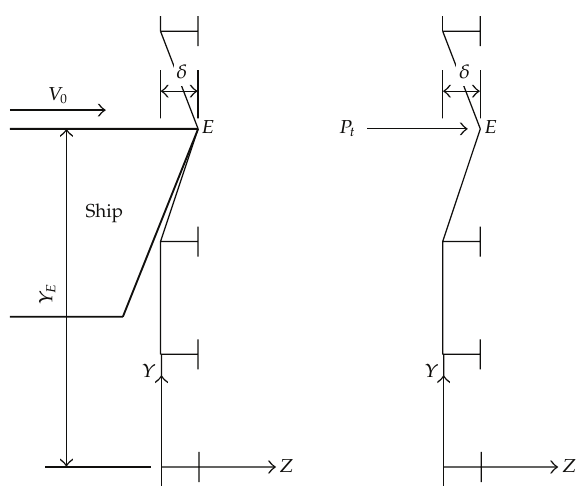
Figure 6: Representation of the impact force.